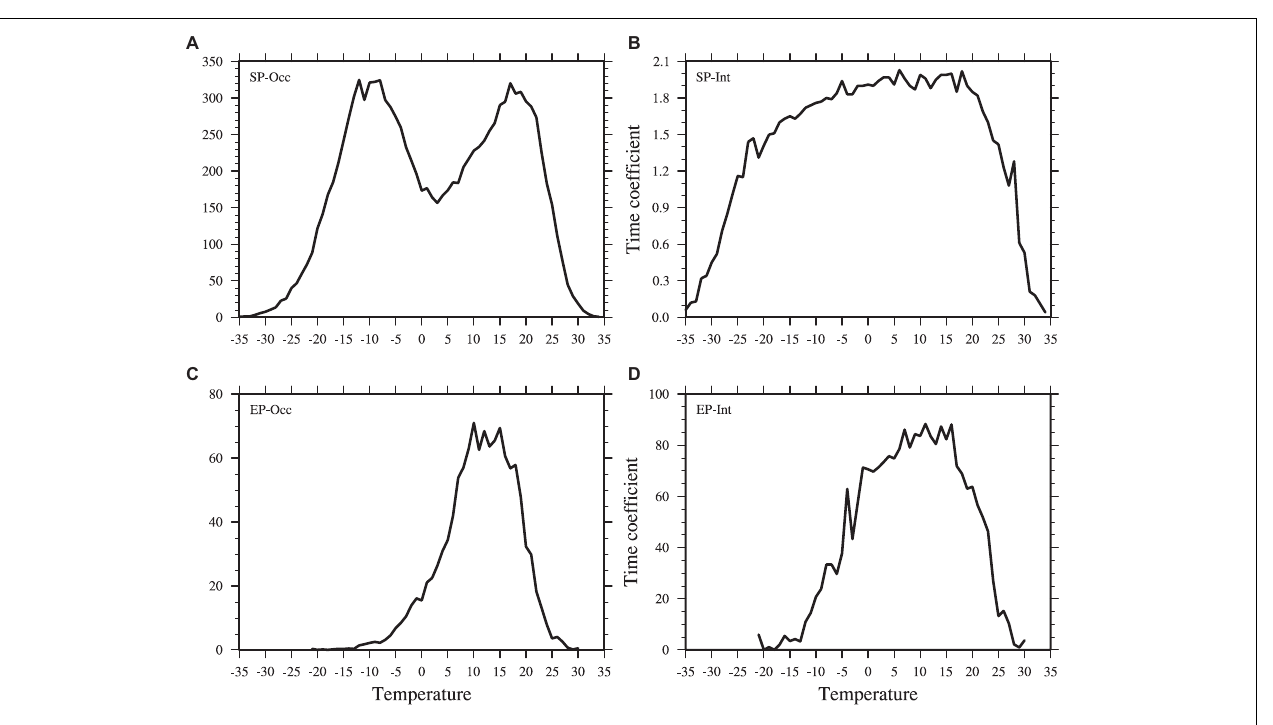
FIGURE 9 | The time coefficient of the first modes from the EOF analysis of variations in (A) SP event frequency, (B) SP event intensity, (C) EP event frequency, and (D) EP event intensity with daily mean temperature